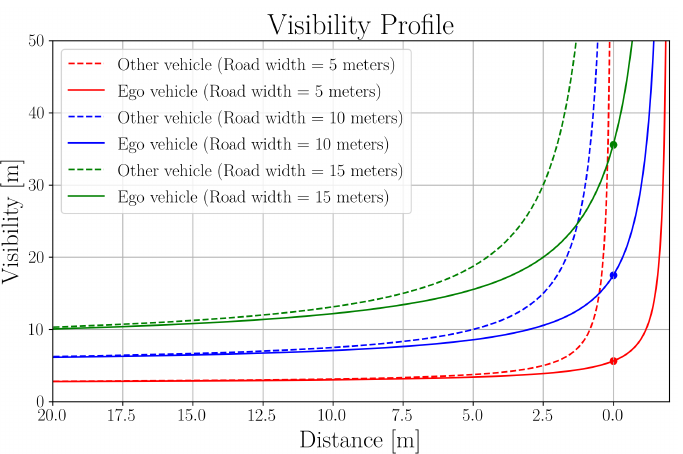
Figure 5. Visibility profiles for ego and other vehicles at blind intersections with roadways of various widths. In each scenario, the ego vehicle’s sensor is located 2 m from the rear of the vehicle’s front bumper. Furthermore, the widths of the ego vehicle’s roadway and the intersecting roadway are assumed to be